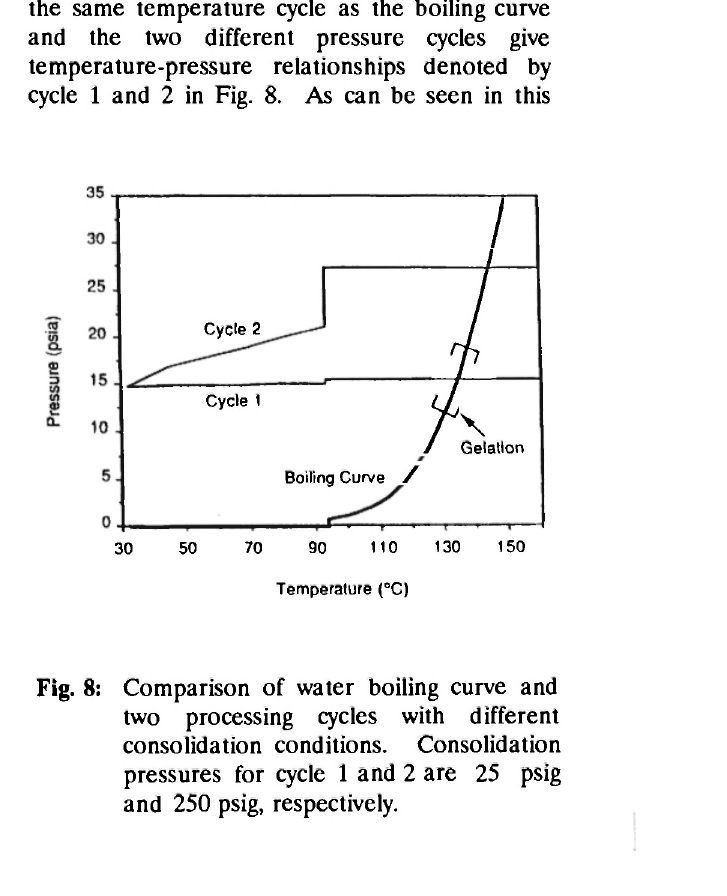
Temperature and pressure consolidation Fig. 7: conditions for phenolic resin composites denoted by cycle 1 and cycle 2 for 25 and (9) 250 psig, respectively.